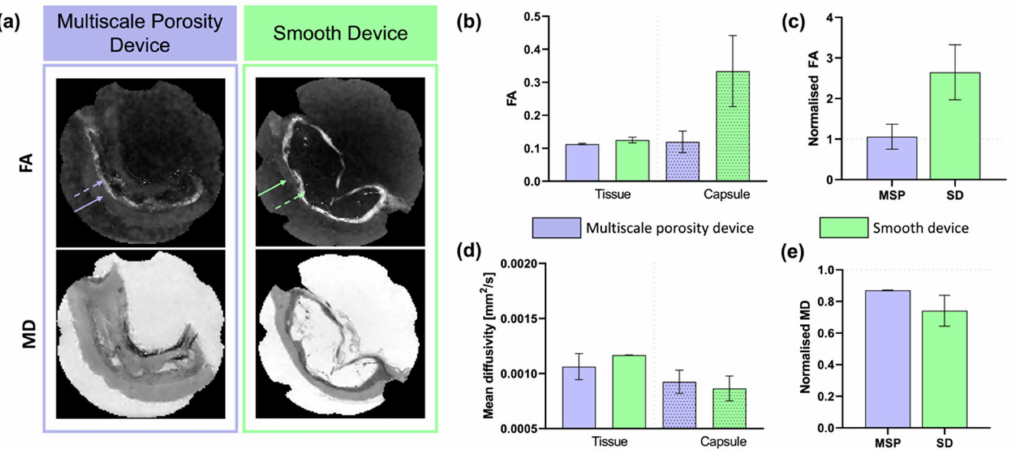
Figure 3. DTI metrics for both devices. ( a ) Fractional anisotropy (top) and mean diffusivity (bottom) maps for both devices. Scales of images match the scales in ( b , d ), respectively. Solid arrows point to tissue regions and dashed arrows to the capsule. ( b , d ) Fractional anisotropy and mean diffusivity shown for the surrounding tissue and the tissue-device boundary (capsule). Capsule regions were normalised by the respective tissue regions per sample to give normalised ( c ) fractional anisotropy and ( e ) mean diffusivity values. A value of 1 indicates no difference between the capsule and surrounding tissue. n = 2 per group; data are represented as means ± standard deviation. No significant difference was determined using Kruskal–Wallis tests. MSP—multiscale porosity device, SD—smooth